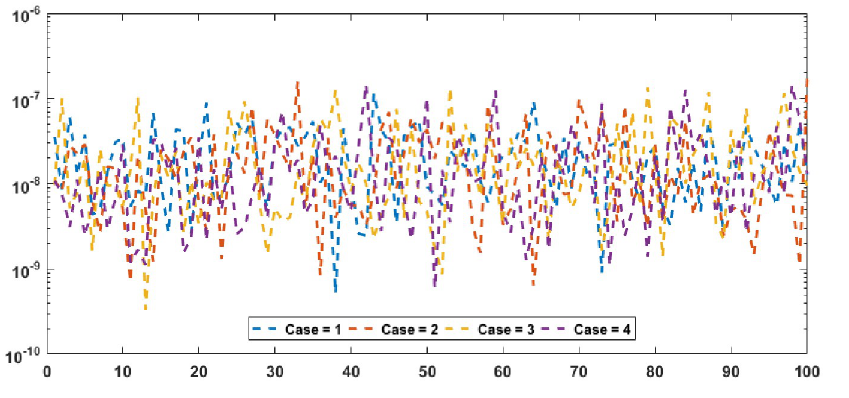
Fig 11. TIC values for each case of problem